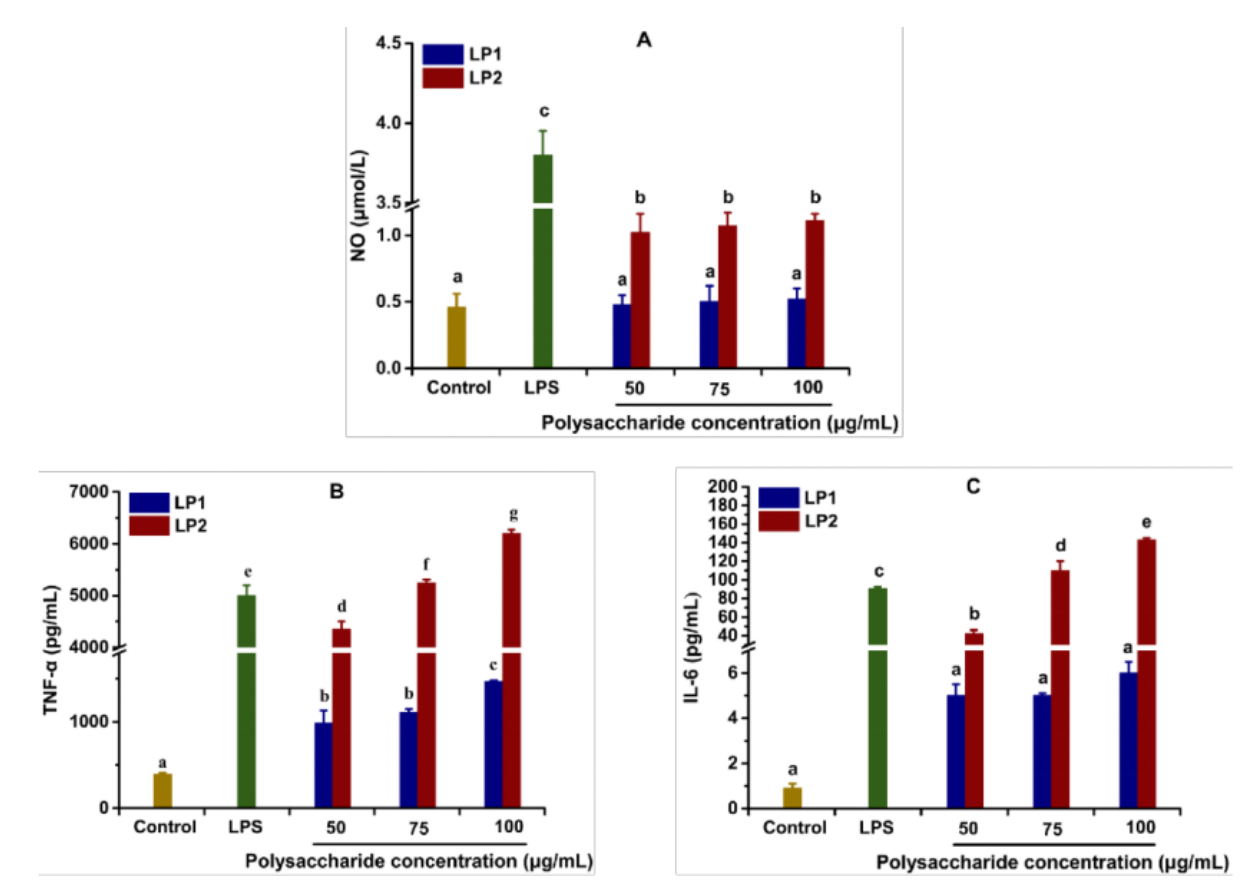
Figure 3. Stimulation effect of LP1 and LP2 on RAW264.7 macrophages. ( A ) NO, ( B ) TNF- α and ( C ) IL-6. Bars labeled with different letters represent a statistical difference at p < 0.05.